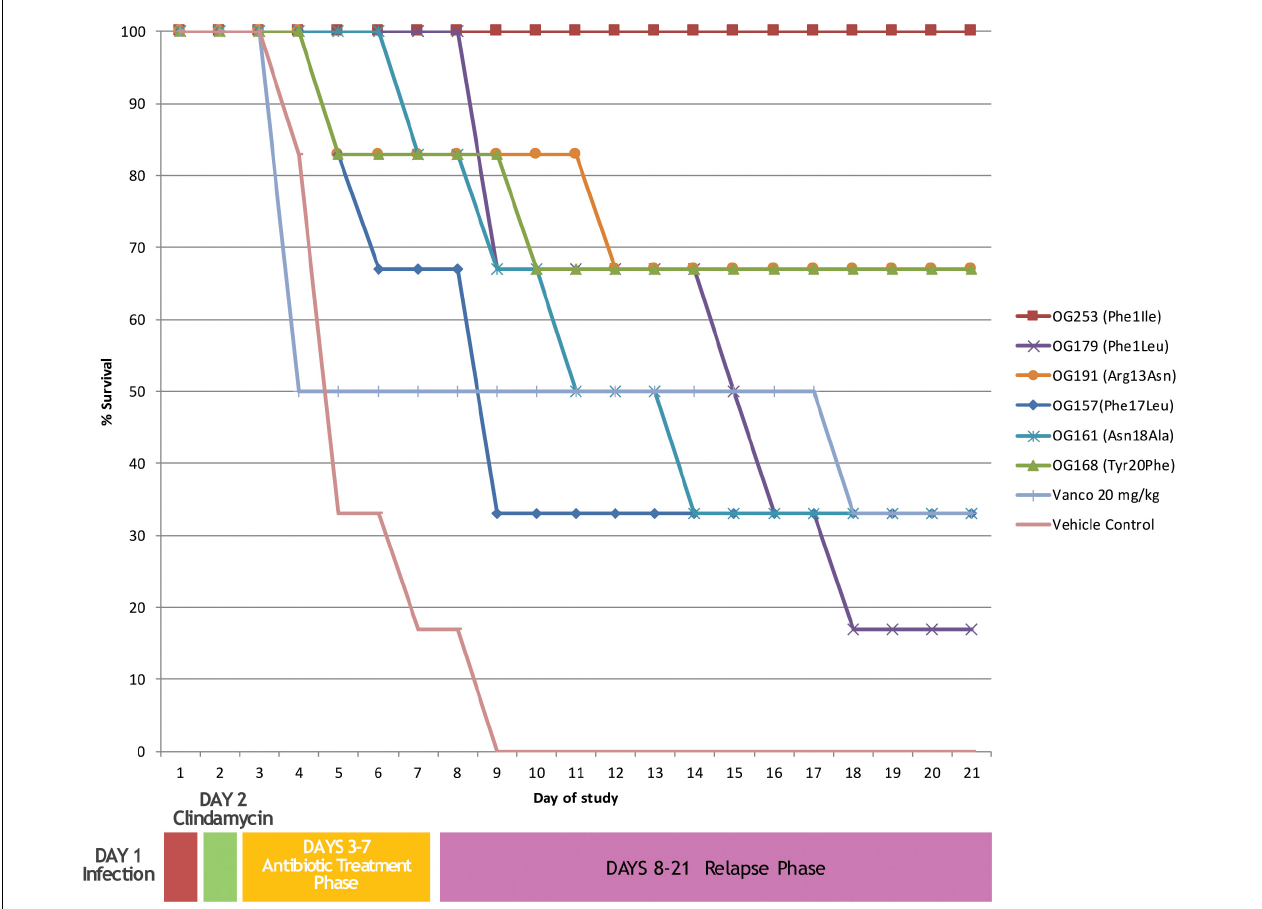
FIGURE 3 | In vivo efficacy of top performers. Animals were infected on day 1 followed by clindamycin treatment on day 2. Antibiotics treatment was from days 3–7 and relapse was monitored from until day